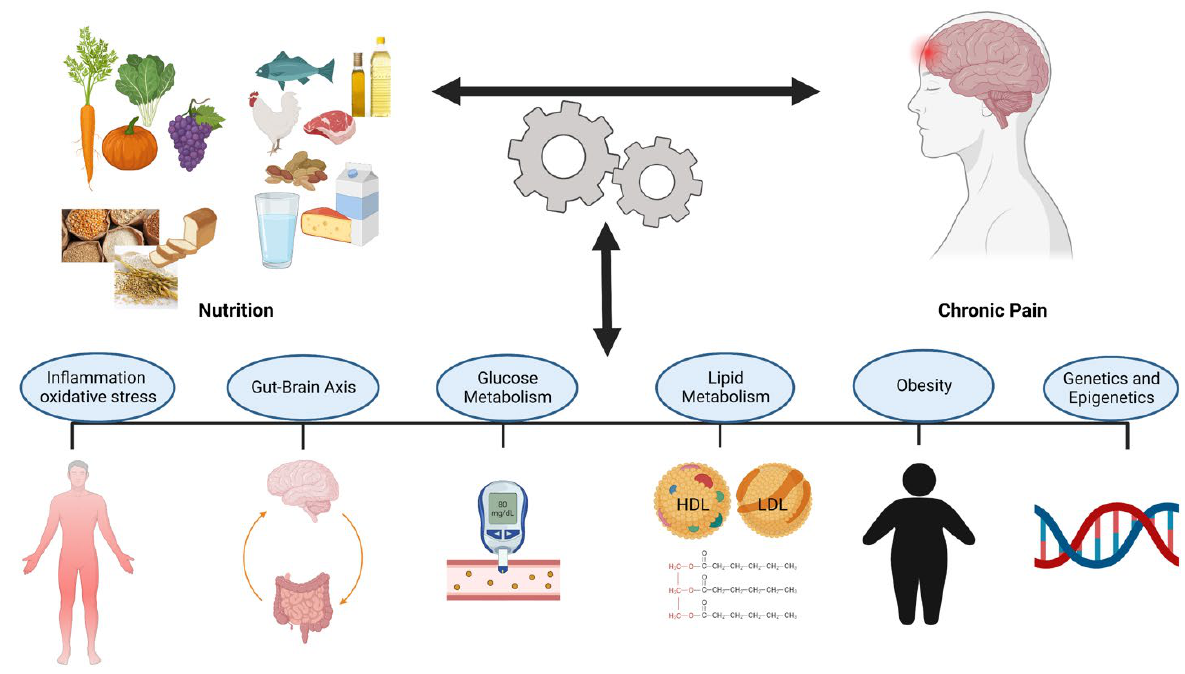
Figure 2. Potential Mechanisms of the Interaction Between Nutrition and Chronic Pain.